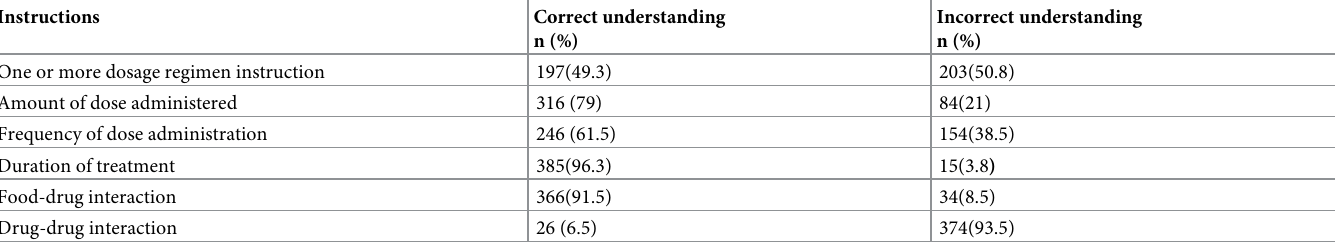
Table 2. Proportion of the study participants with respective understanding level of dosage regimen instructions (N =